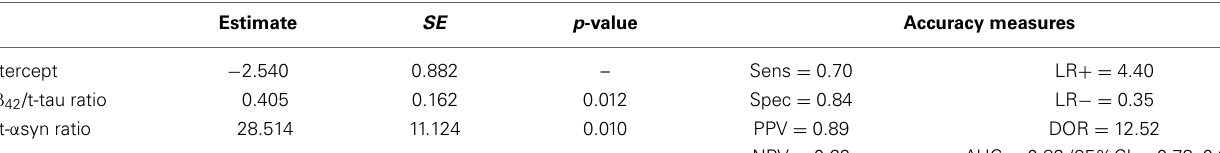
Table 5 | Logistic regression analysis of multiple CSF biomarkers between PD and OND. Estimate SE p -value Accuracy measures Intercept